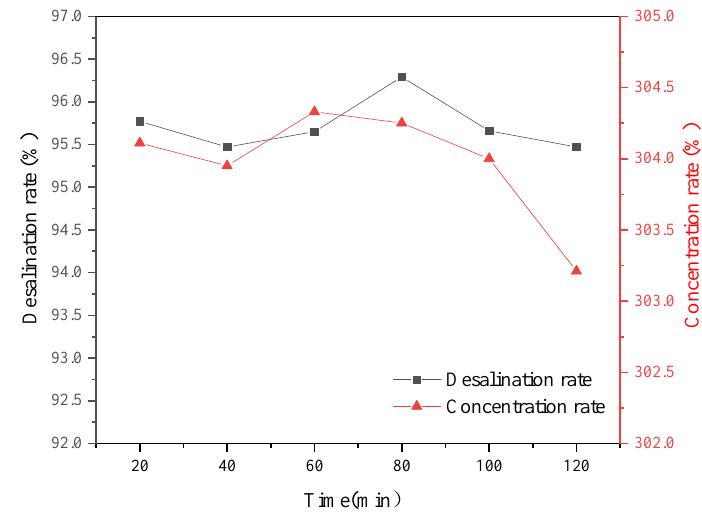
Figure 12. Effect of time on the desalination and concentration rates.